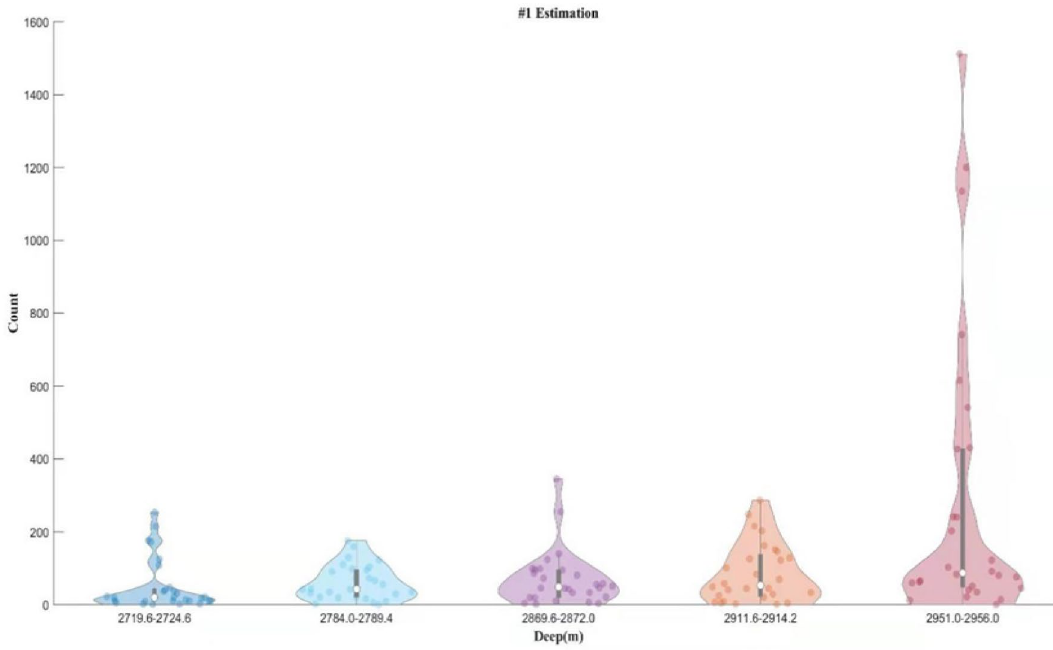
Fig. 6 fiber vibration sound low frequency signal distribution